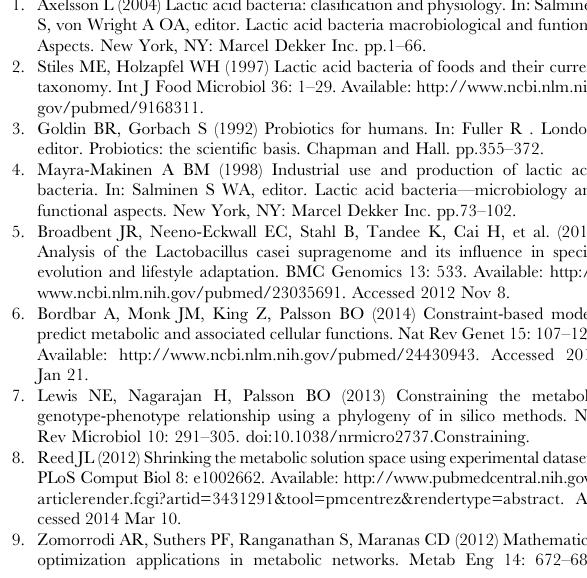
Table S5 Complete list of reactions and compounds present in GapfillMatrix. Table S6 Complete list of reactions and compounds present in iLca12A_640. Table S7 Complete list of reactions and compounds present in iLca334_548. Table S8 Enzymes and transporters added to L. casei ATCC 334 and 12A models to fix false negative predictions. Addition of an enzyme/transporter is indicated with filled circles; open circles indicate no addition of enzyme/ transporter. Table S9 GapfillMatrix in SBML